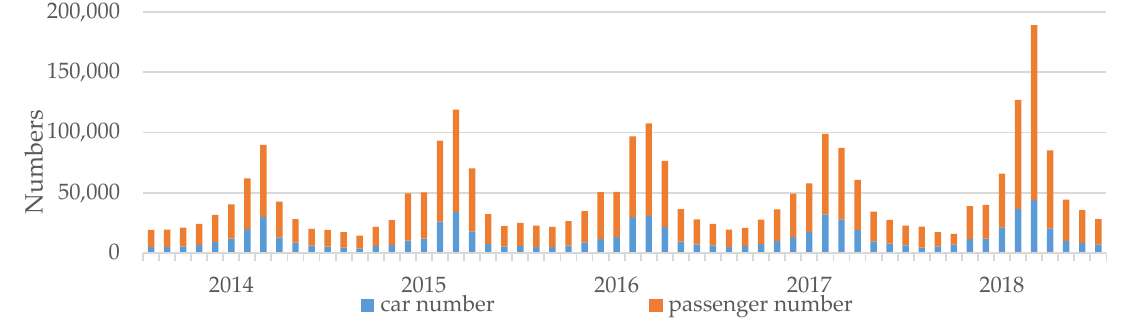
Figure 4. Comparison of the input variables (car and passenger numbers) trend for predicting electricity demand.